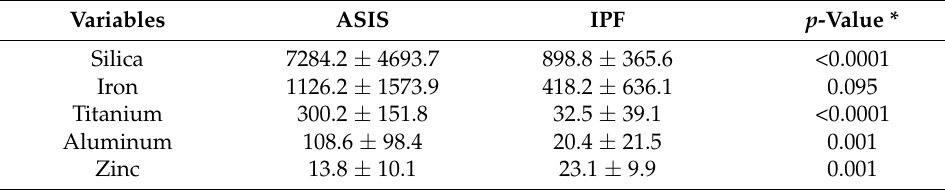
Table 3. Chemical analysis by x-ray fluorescence in lung tissues (34 patients). Variables